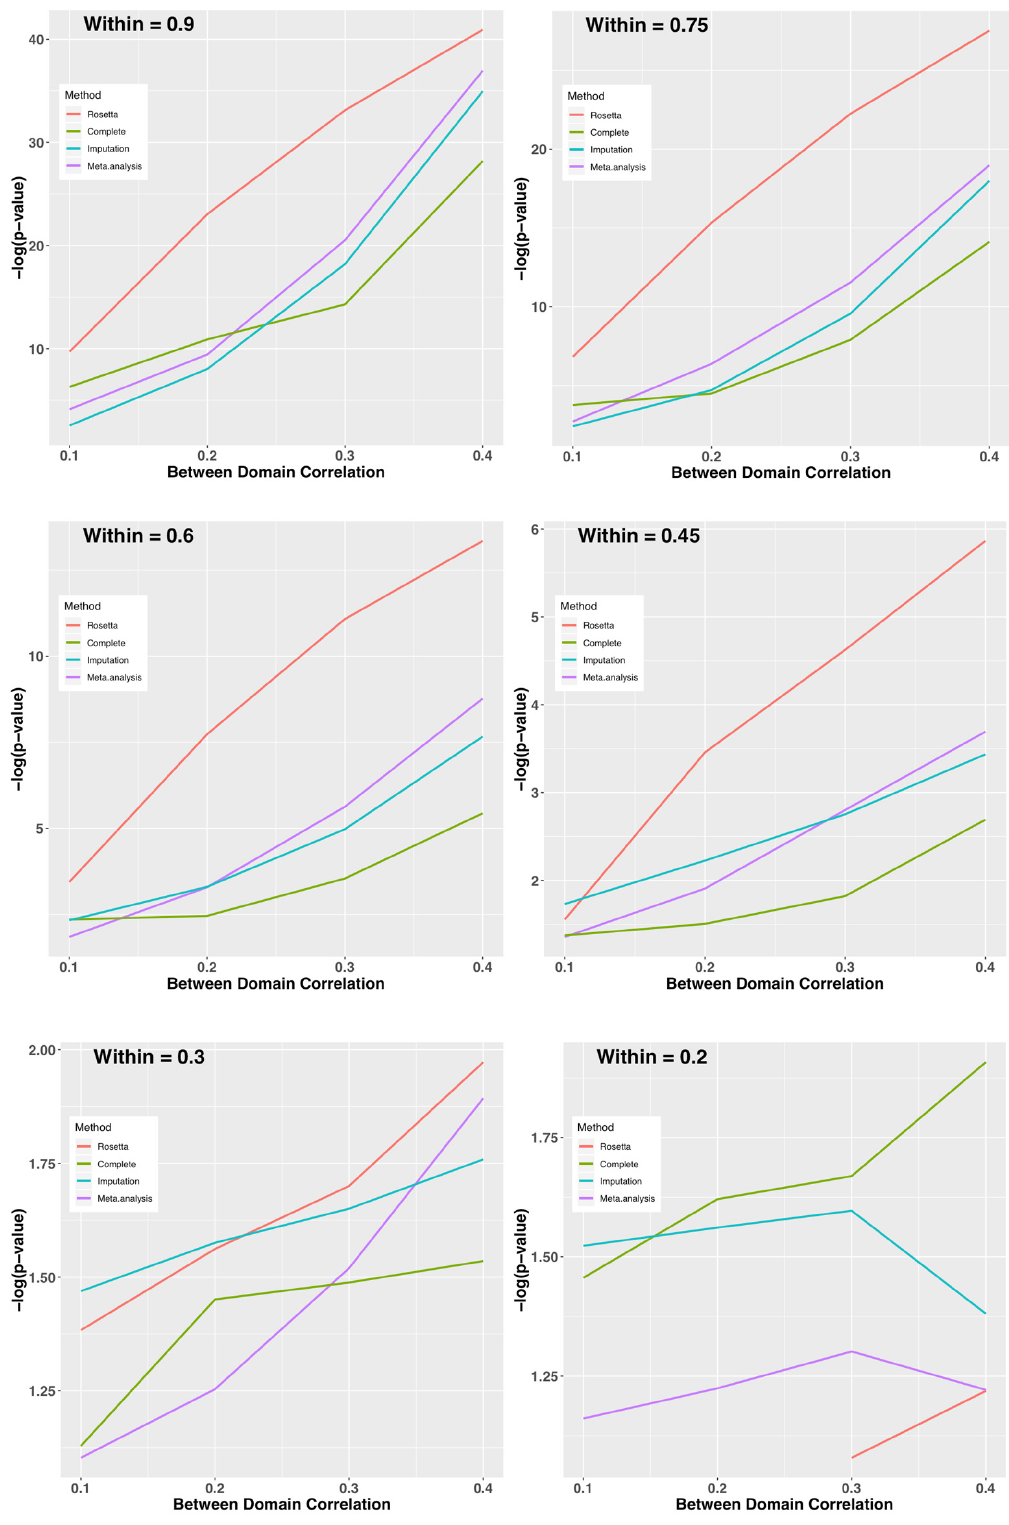
Figure 4. Study 3: Average –log( p -value) on the y-axis for Each Method by Within-Domain Correlation (panels) and Between-Domain Correlation (x-axis). Provided the within-domain correlation is > 0.3 on average, ROSETTA shows a clear advantage for downstream analysis. When the within-domain correlation is 0.2 or less, the current implementation of ROSETTA runs into numerical issues and can no longer be applied.